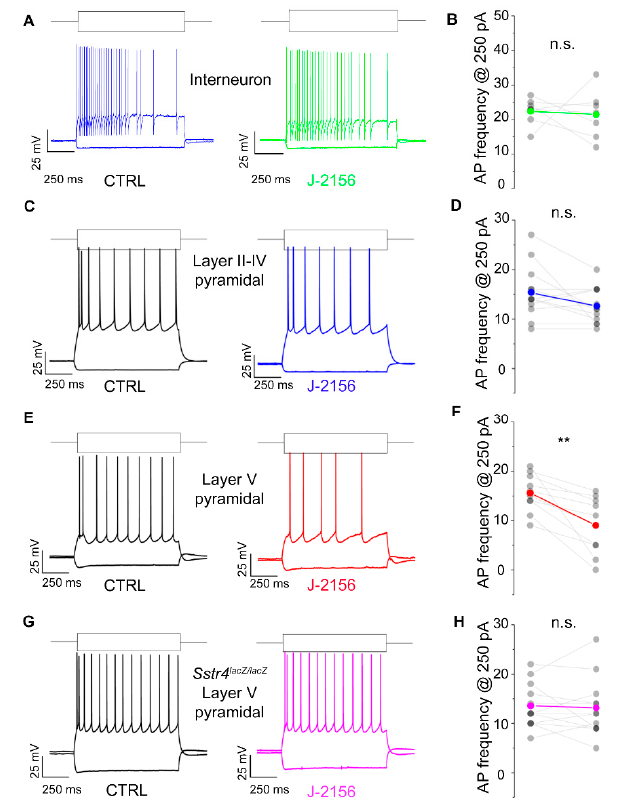
Figure 6. SST 4 receptor activation decreases firing frequency of layer V pyramidal cells of the